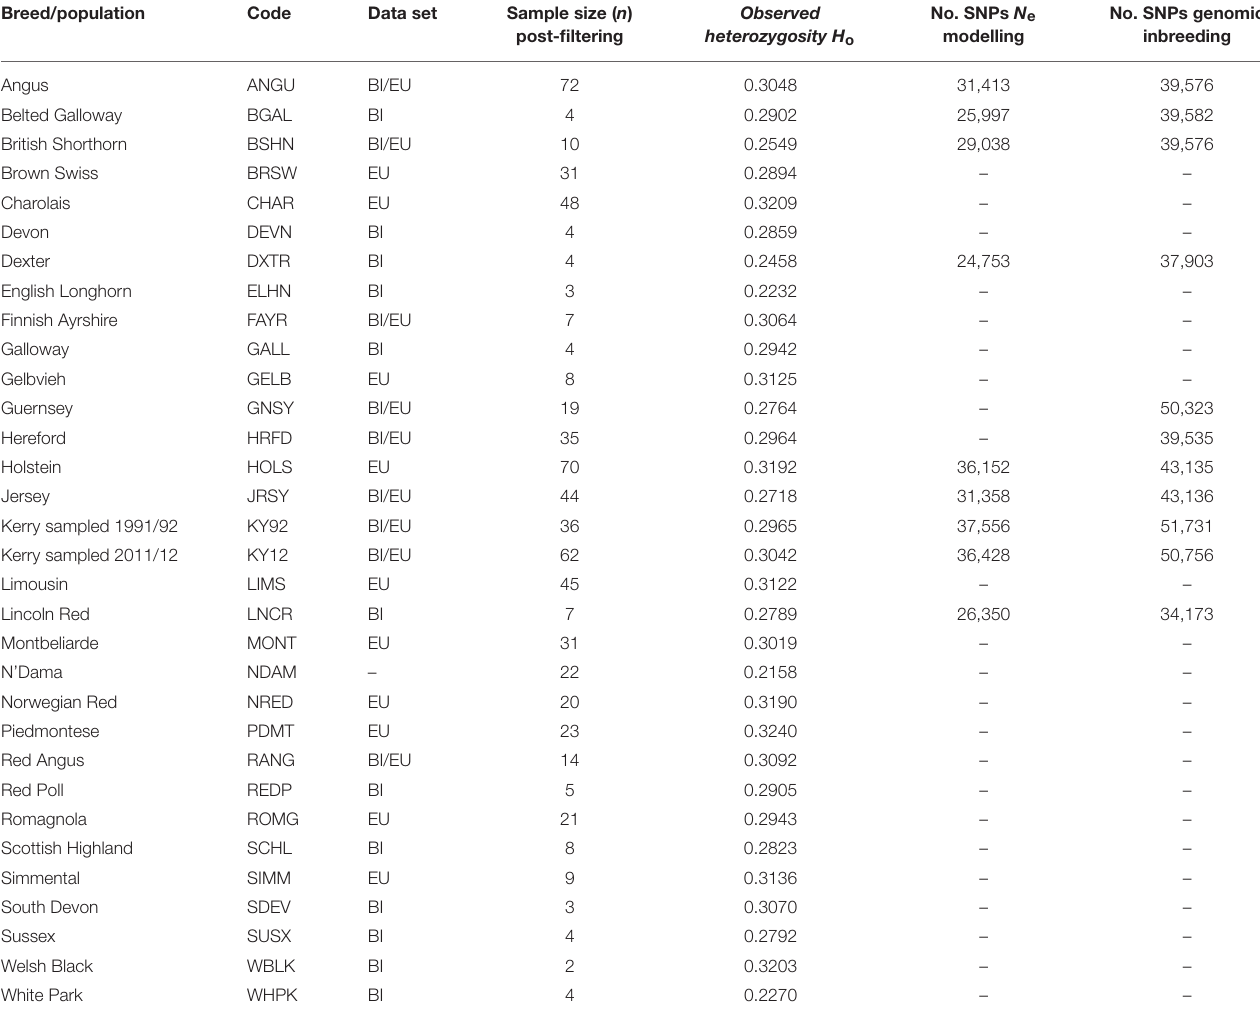
TABLE 2 | Breed/population sample size, observed heterozygosity and SNP filtering information.